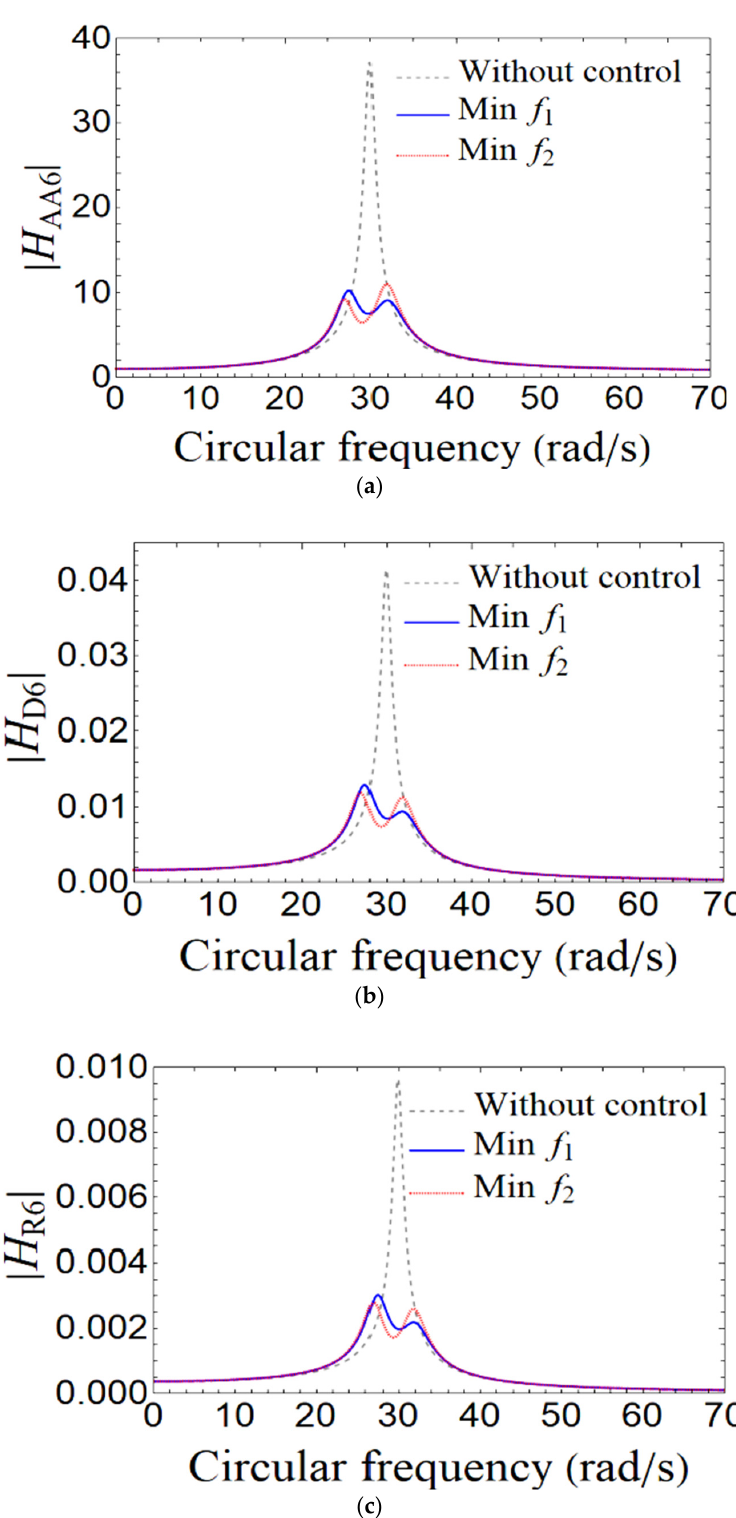
Figure 5. Frequency response of: ( a ) 6th node vertical absolute acceleration transfer function ( ω ) | , ( b ) absolute displacement transfer functions | H | H AA 6 tational transfer function | H R 6 ( ω ) | for f 1 and f 2 minimization of the first mode